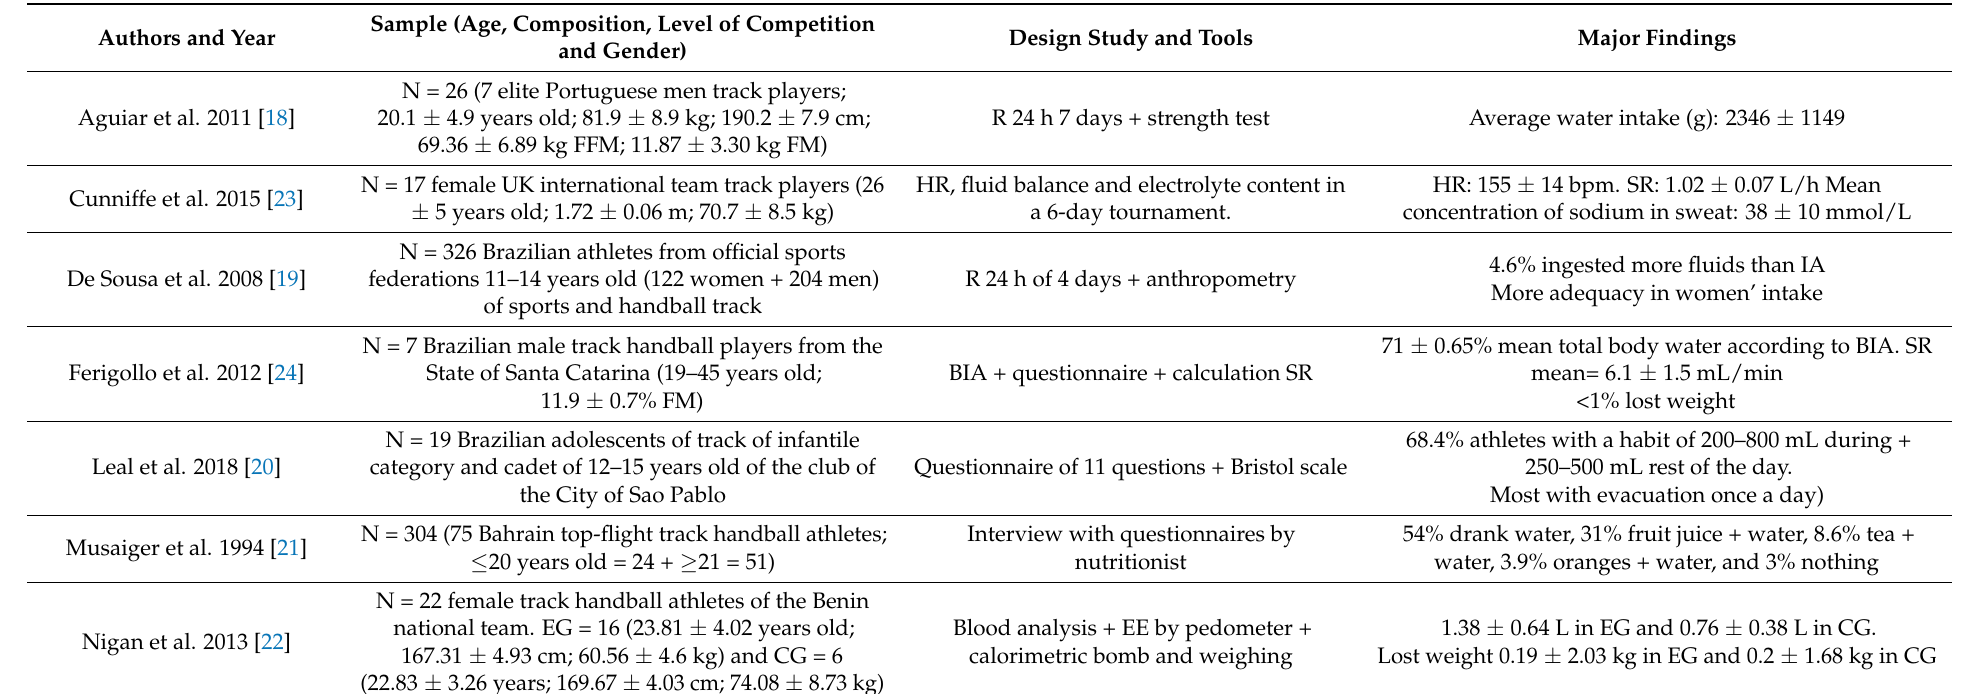
Table 1. Evaluation of hydration, water intake and water